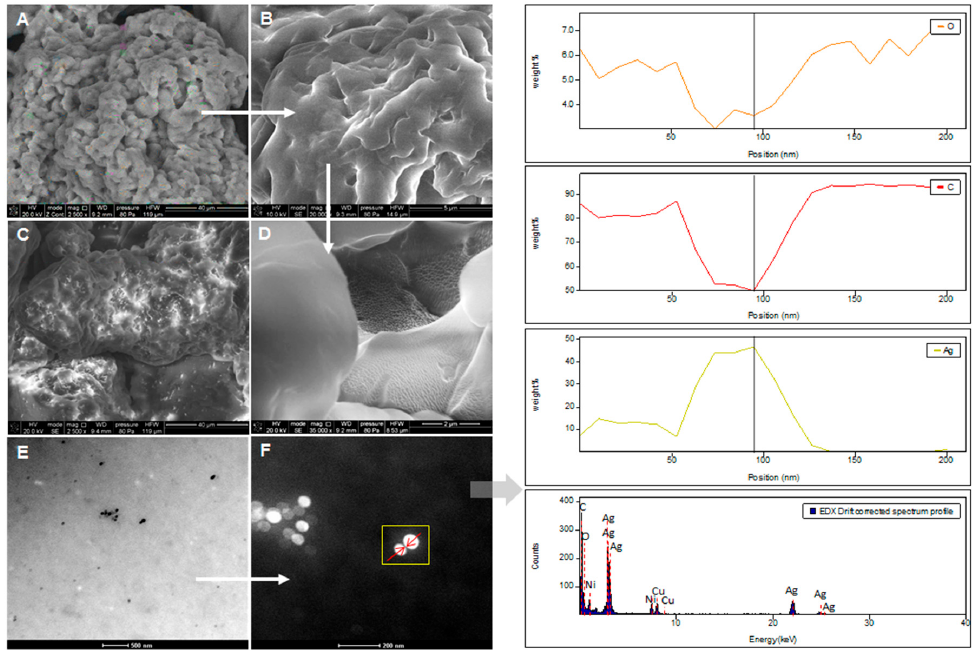
Figure 7. SEM image of native casein ( A , B , D ); SEM image of casein-silver complexes ( C ); TEM image of casein-silver complexes with the EDX spectra and EDS (Energy Dispersive Spectroscopy) elemental line scans ( E , F